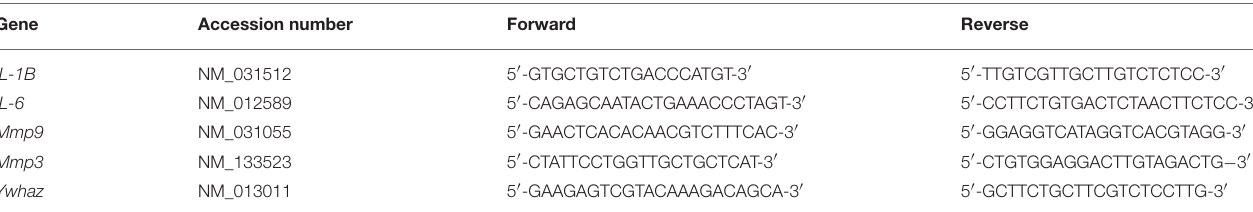
TABLE 1 | Primer sequences for qRT-PCR